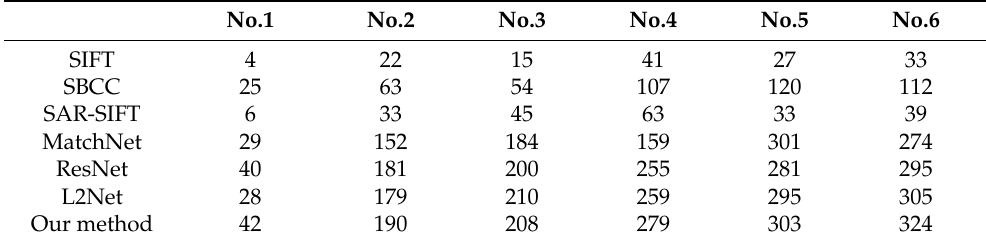
Table 4. The Number of Point